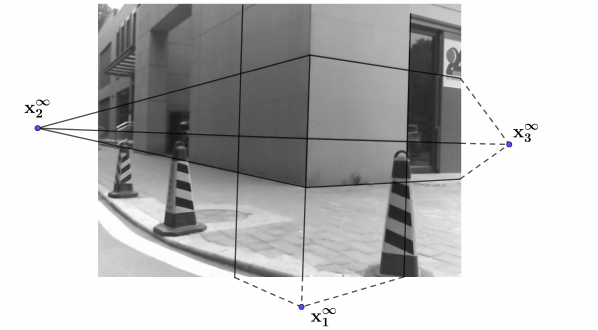
Figure 3. Corresponding points on an image